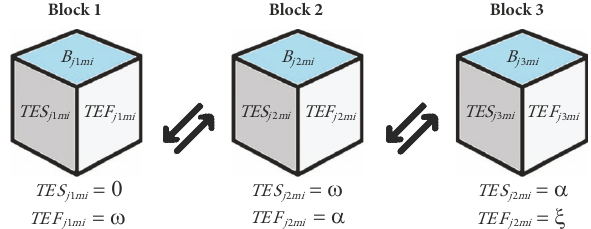
Figure 6. The sequencing block information from Step 5